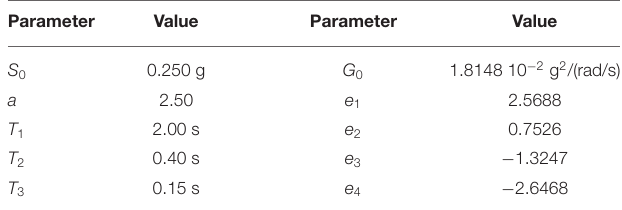
TABLE 1 | Parameters for the definition of the design earthquake in terms of Response Spectrum and PSD function.